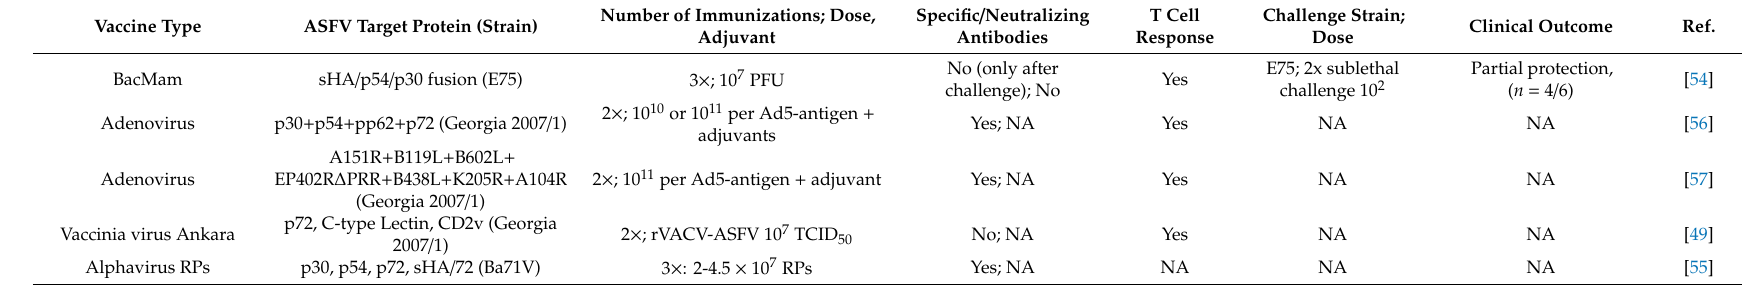
Table 3. Virus vector-based ASFV vaccines evaluated in the swine